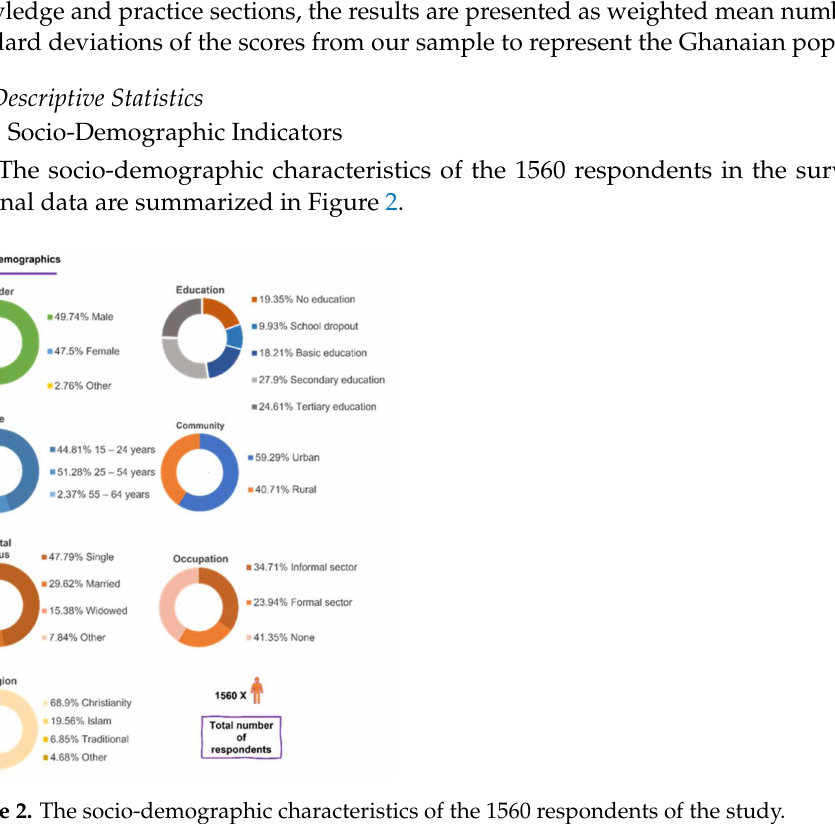
Figure 2. The socio-demographic characteristics of the 1560 respondents of the study.